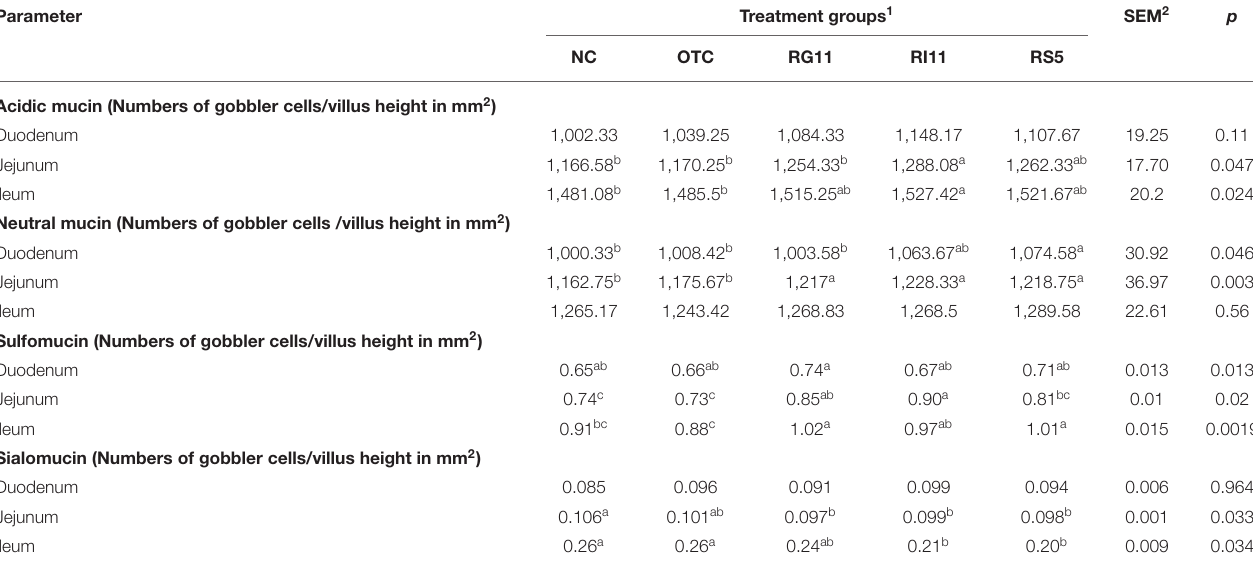
TABLE 10 | Goblet cell mucin composition of broiler chickens when fed with different postbiotics during the finisher period.